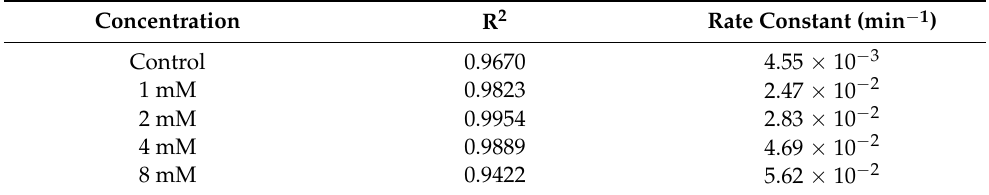
Table 7. Variations in the pseudo-first-order rate constant by increasing the concentration of persul- fate